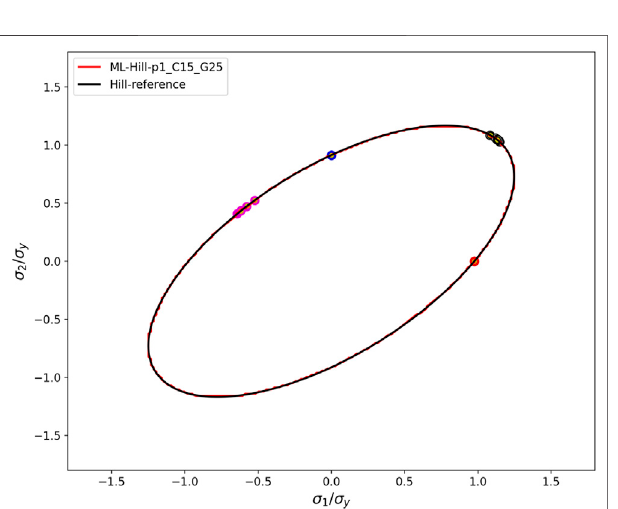
FIGURE 13 | The two non-zero principal values of the fl ow stresses (colored circles) and yield loci of the trained ML fl ow rule (red line) and the Hill- type reference material (black line) are plotted for four different load cases of the 2D plane stress model. The large colored circles represent the fl ow stressesresultingfromtheMLyieldfunction,andthesmallyellowcirclesshow fl ow stresses from the analytical Hill-type yield function.